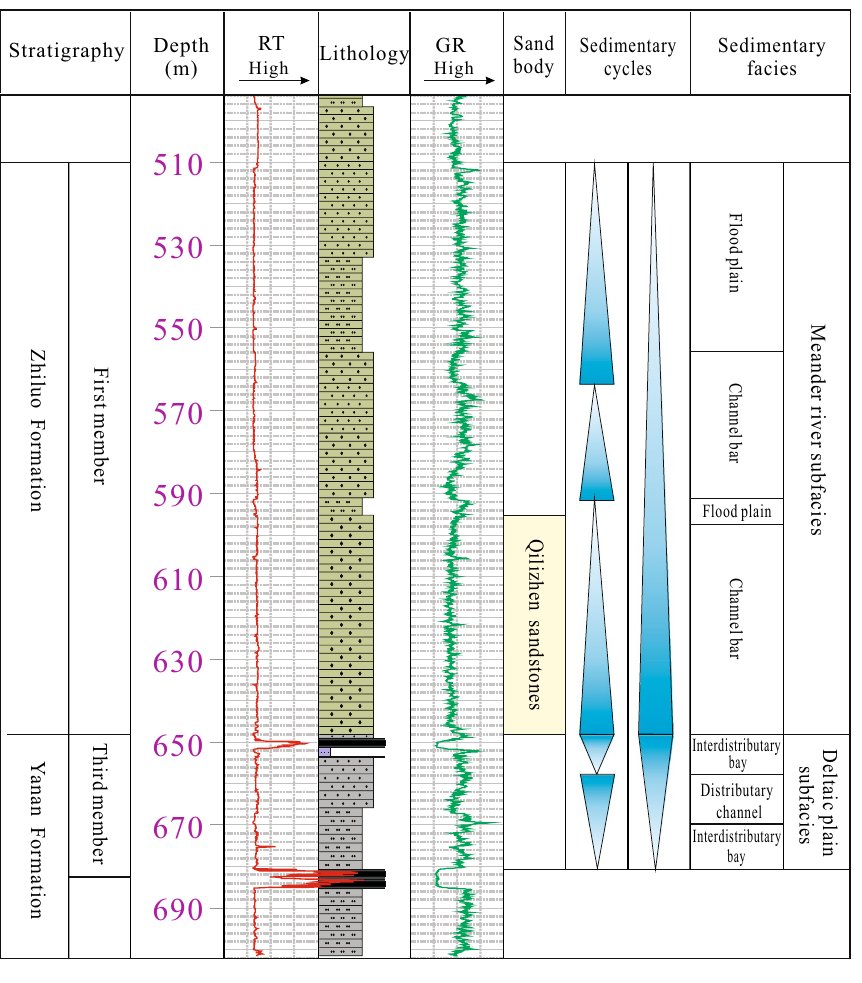
Figure 5. Sedimentary facies analysis of well